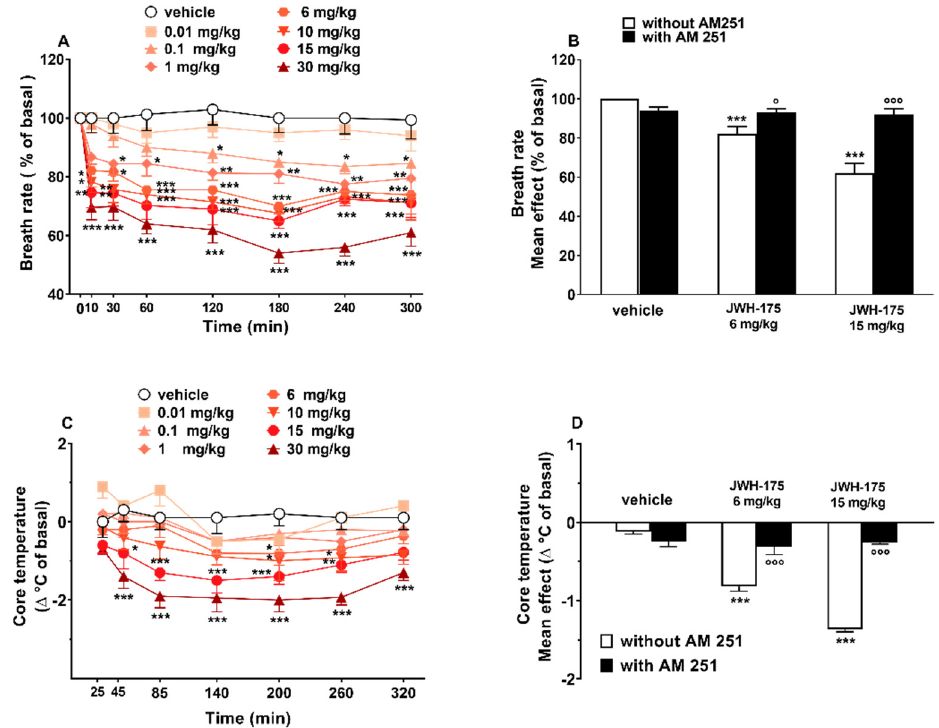
Figure 5. Effect of JWH-175 (0.01–30 mg/kg i.p.) on the breath rate ( A ) and core body temperature ( C ) in mice. Interactions of JWH-175 with the selective CB1 receptor antagonist AM-251 (6 mg/kg i.p.) are reported in histograms ( B , D ). Data are expressed as percentage of baseline (breath rate) and as the difference between control temperature (before injection) and temperature following drug administration ( Δ °C of basal) and represent the mean ± SEM of 8 animals for each treatment. Statistical analysis was performed by two-way ANOVA followed by Bonferroni’s test ( A , C ) for multiple comparison for the dose–response curve of each compound at different time-points. The analysis of the mean overall effect of each compound and AM-251 ( B , D ) was performed with one-way ANOVA followed by Tukey’s test. * p < 0.05, ** p < 0.01, *** p < 0.001 versus vehicle; ° p < 0.05, °°° p < 0.001 versus JWH-175.